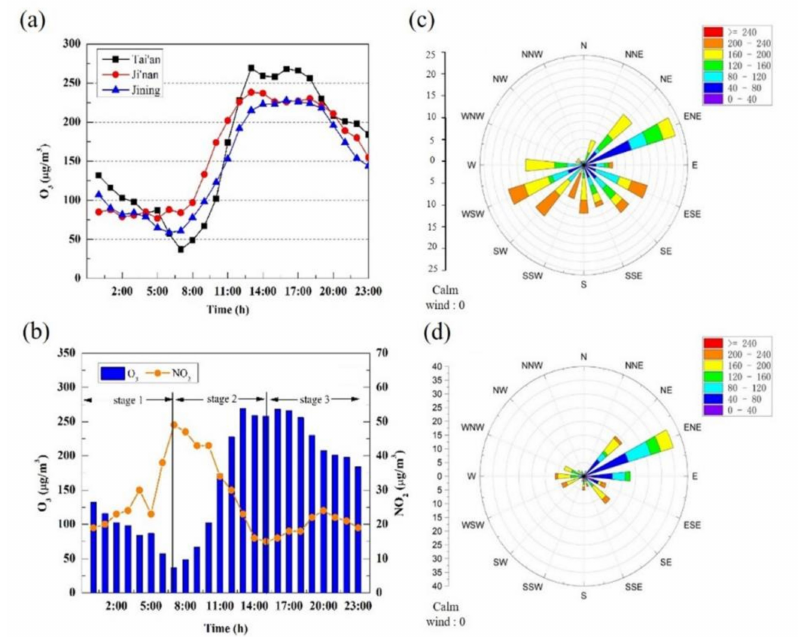
Figure 5. Comparisons of ( a ) diurnal variations of O 3 among Tai’an and surrounding cities and ( b ) diurnal variations of hourly O 3 and NO 2 concentrations in Tai’an on 21 June 2021; wind rise of observed O 3 concentrations in Tai’an during ( c ) 3–9 July and ( d ) 7–12 August 2021.